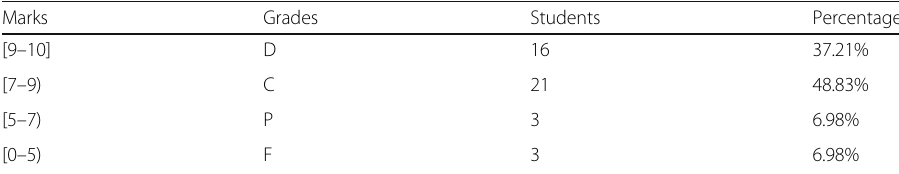
Table 5 Final assignment grades of the students